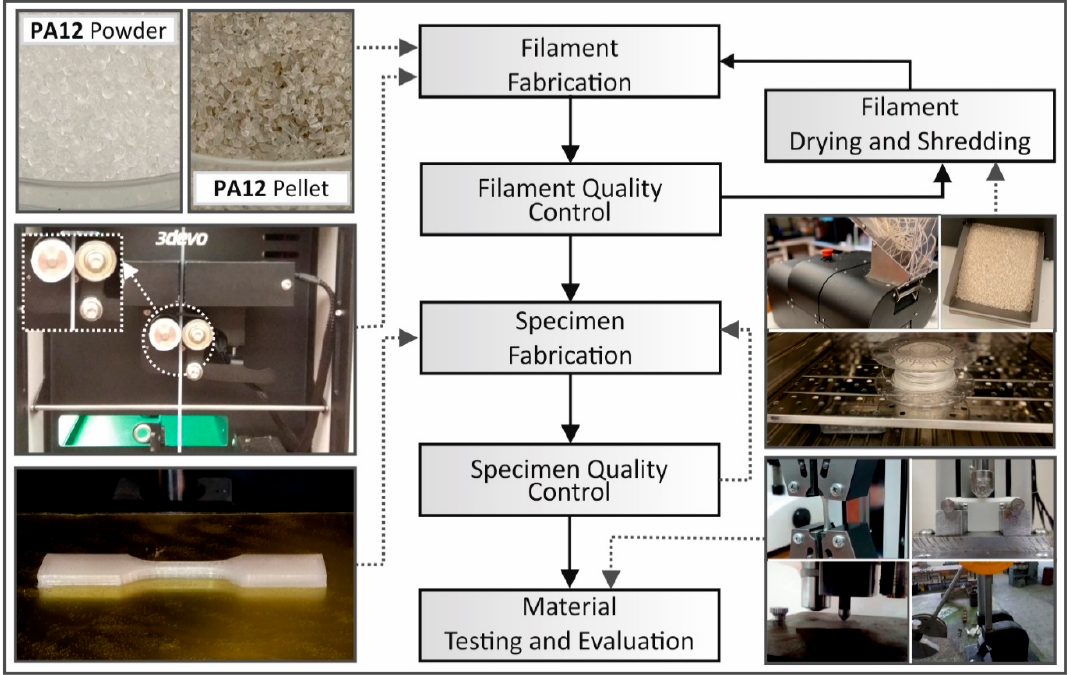
Figure 2. Flow chart with the methodology followed for the PA12 recycling in the current study. The shredder machine that was utilized in order to reshape the filament into pellets was a Shreddit (3D Evo B.V., Utrecht, The Netherlands). Through all recycling courses, the extrusion parameters in the 3D Evo Composer 450 (3D Evo B.V., Utrecht, The Netherlands) were kept constant. More specifically, heat zone 1 (closer to extruder’s nozzle) was set to 210 ◦ C, heat zone 2 was set to 220 ◦ C, heat zone 3 was set to 220 ◦ C and finally heat zone 4 (closer to extruder’s hopper) was set to 185 ◦ C. Extruder’s screw rotational speed was